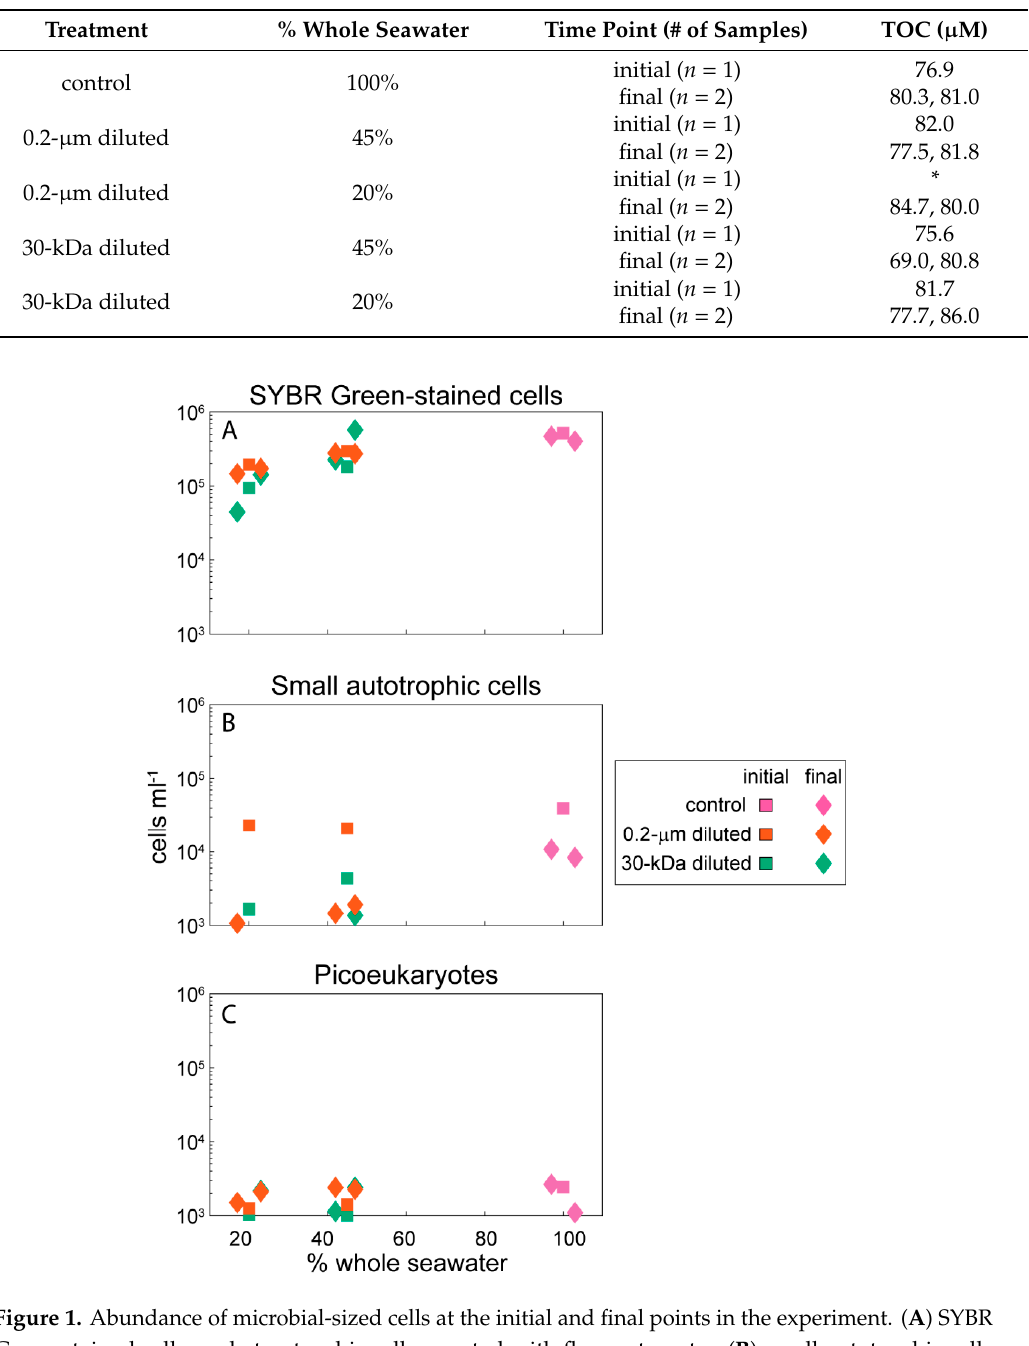
Table 1. Experimental design and concentrations of total organic carbon (TOC) in each treatment at the initial and final time points. The control is 100% whole seawater, while the 0.2- µ m and 30-kDa treatments were diluted with water passed through 0.2- µ m and 30-kDa filters, respectively. The table provides the amount each treatment was diluted. * The initial TOC sample for the 0.2- µ m treatment with 20% whole seawater was lost.